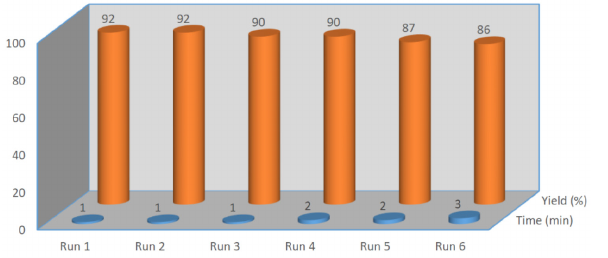
Figure 10: Reusability of the CuFe aniline.